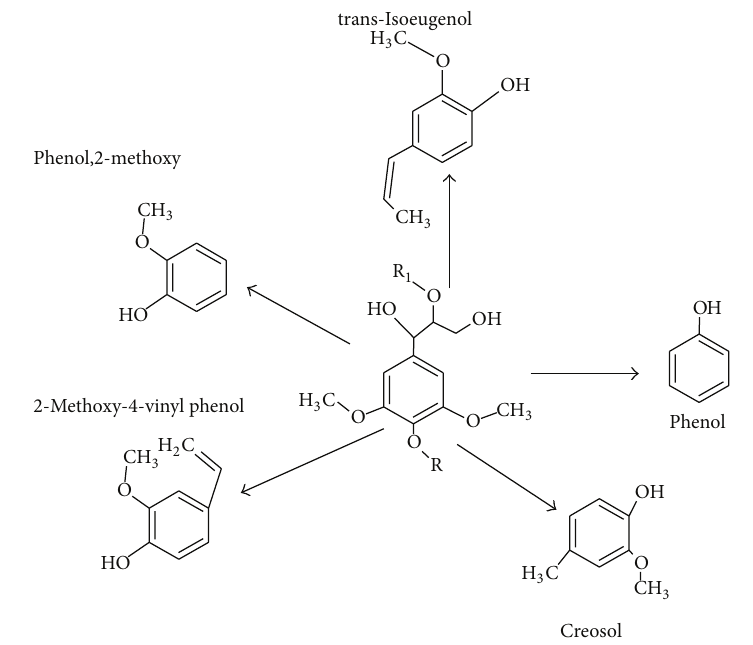
Figure 6: The schematic diagram of the lignin decomposition at high temperature ( > 773 K). those formed at higher temperature ( > 773 K). The aromatic compounds are produced due to the decomposition of